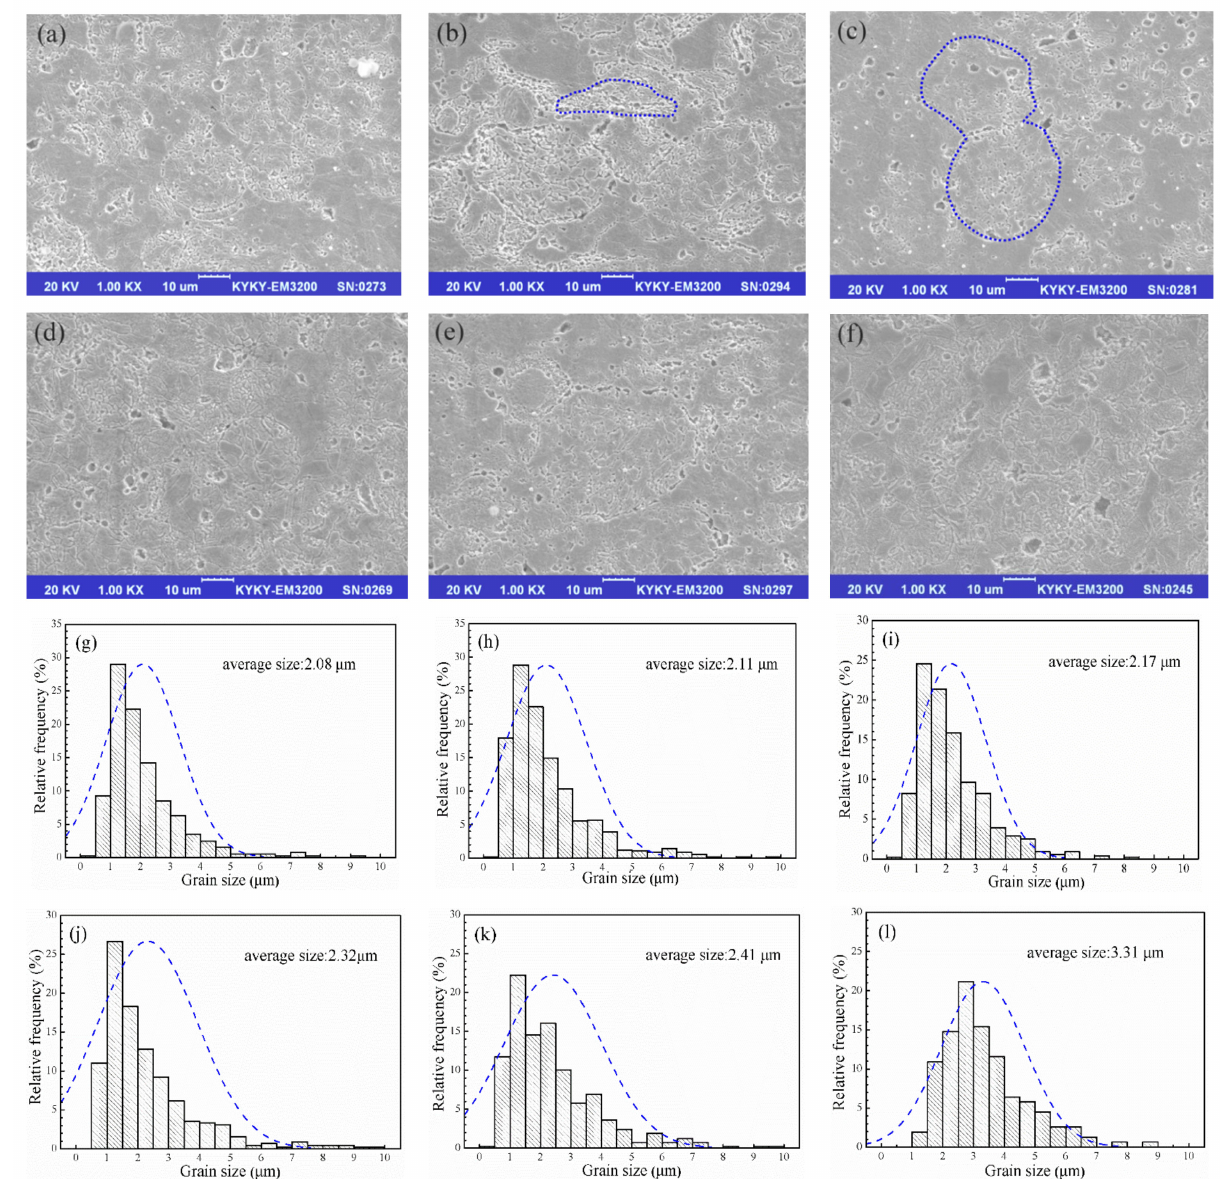
Figure 3. SEM images and grain sizes of nano-Gd 2 O 3 /Cu composites and Cu: ( a – e , g – k ) Gd 2 O 3 /Cu at sintering tempera- tures of 1123–1223 K with an interval of 25 K; ( f , l ) pure Cu at a sintering temperature of 1173